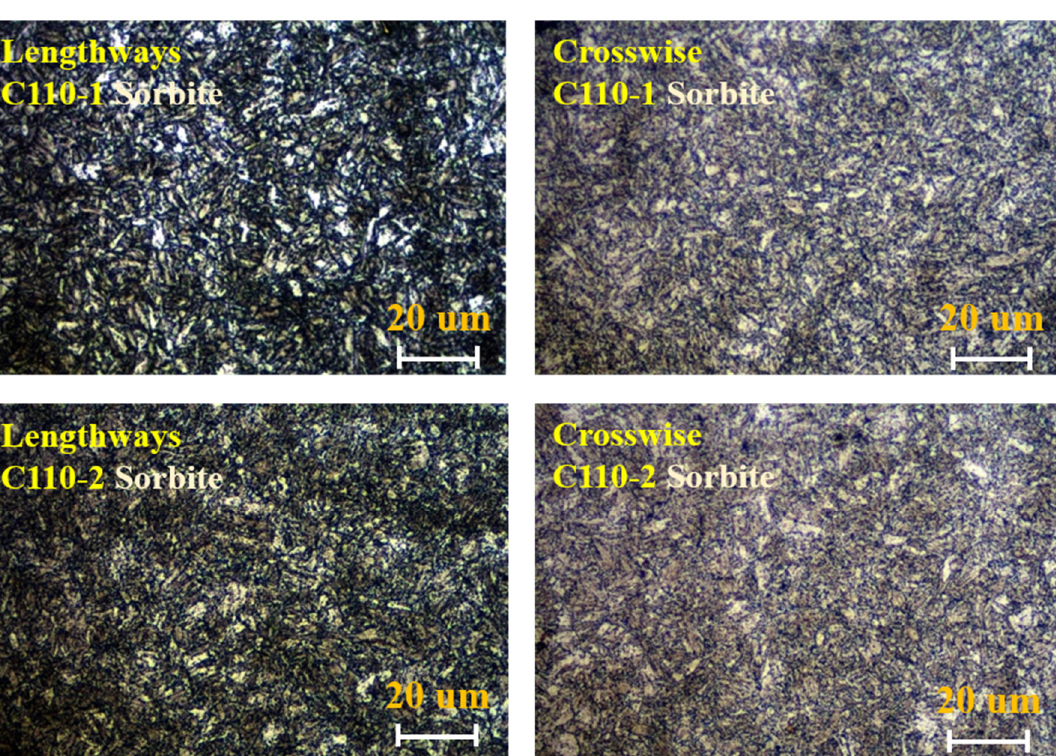
Figure 9. Metallographic structure of C110-1 and C110-2.